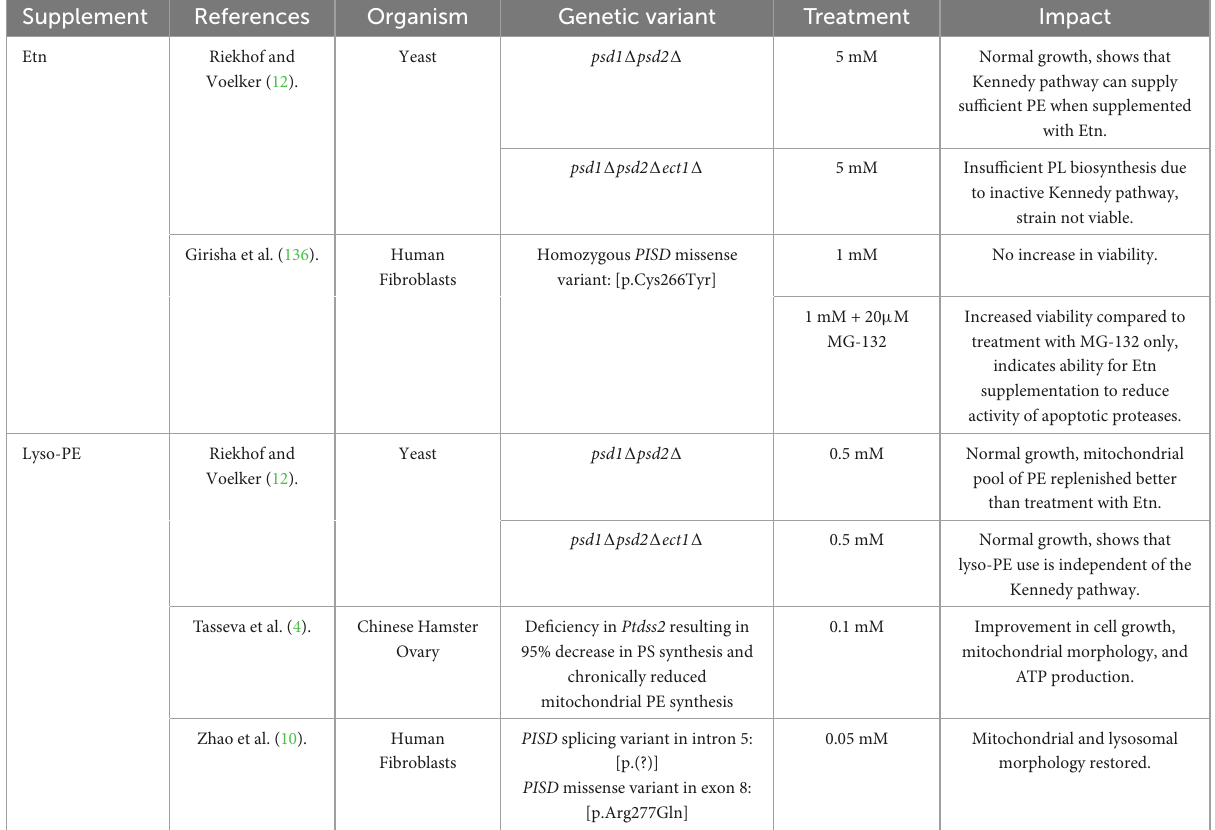
TABLE 2 Summary of studies that investigated the impact of Etn and lyso-Etn supplementation on PL homeostasis.